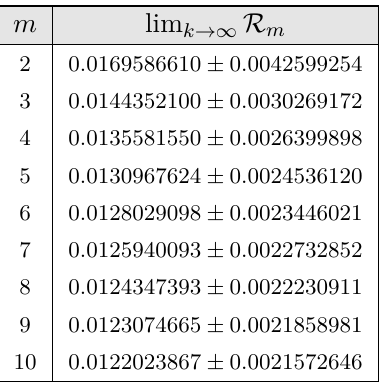
Figure 24. Variation of Rényi entropies for the state | 6 3 # T 2 , 2 i with k